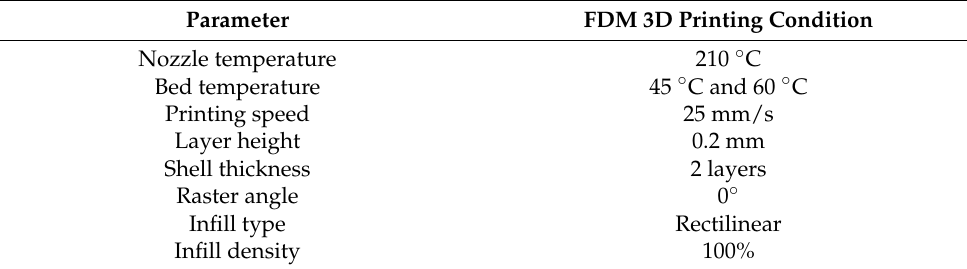
Figure 1. 3D printing sample preparation: ( a ) Printing direction; ( b ) size of dumbbell specimen; and ( c ) cross sectional for morphology observation. Table 2. Conditions of FDM 3D